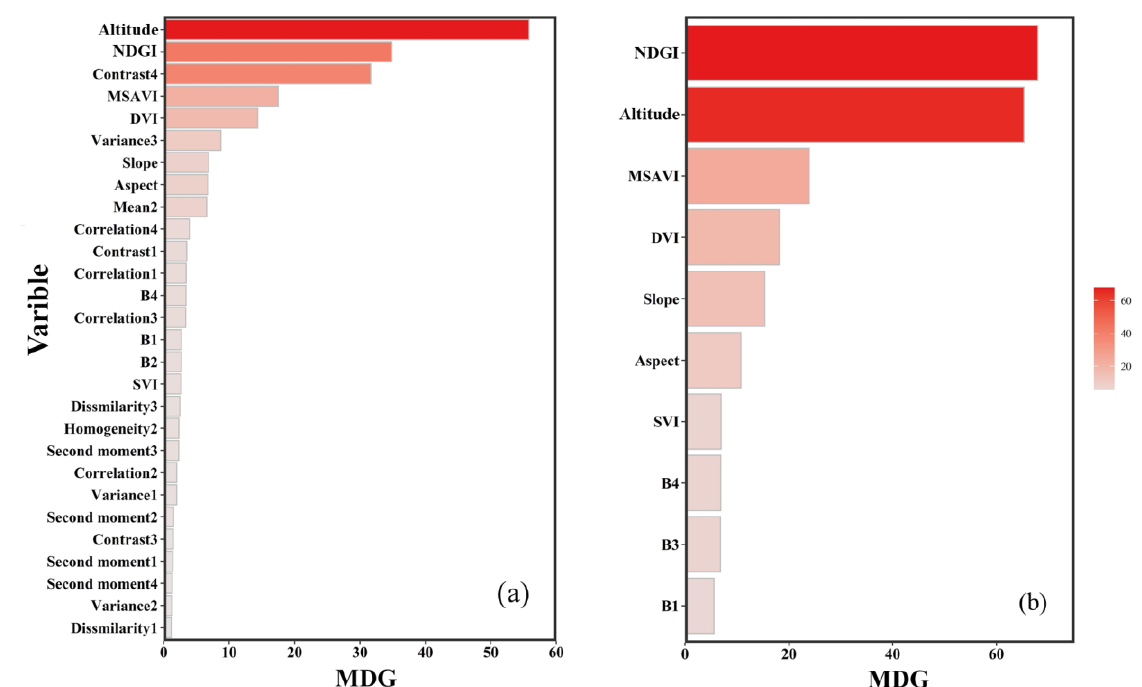
Figure 5. Relative importance of variables: ( a ) Scheme 11; ( b ) Scheme 8.